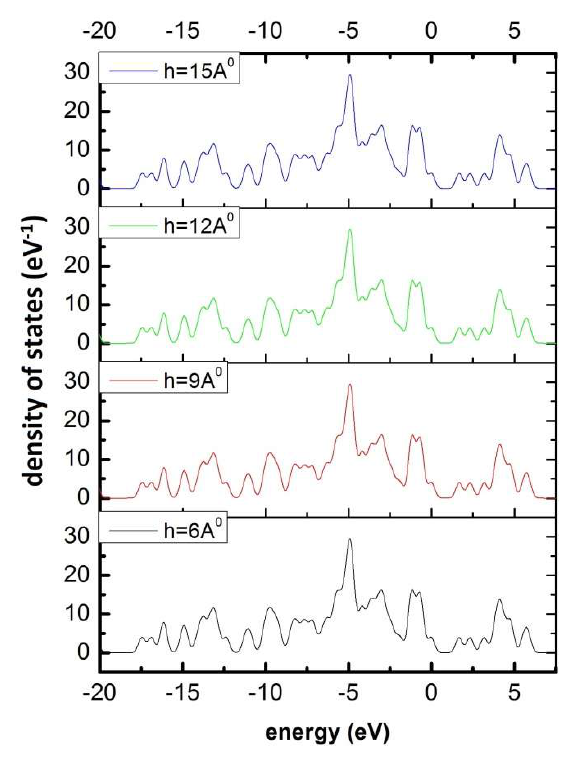
Figure 3. The electronic density in the chemotherapy band.